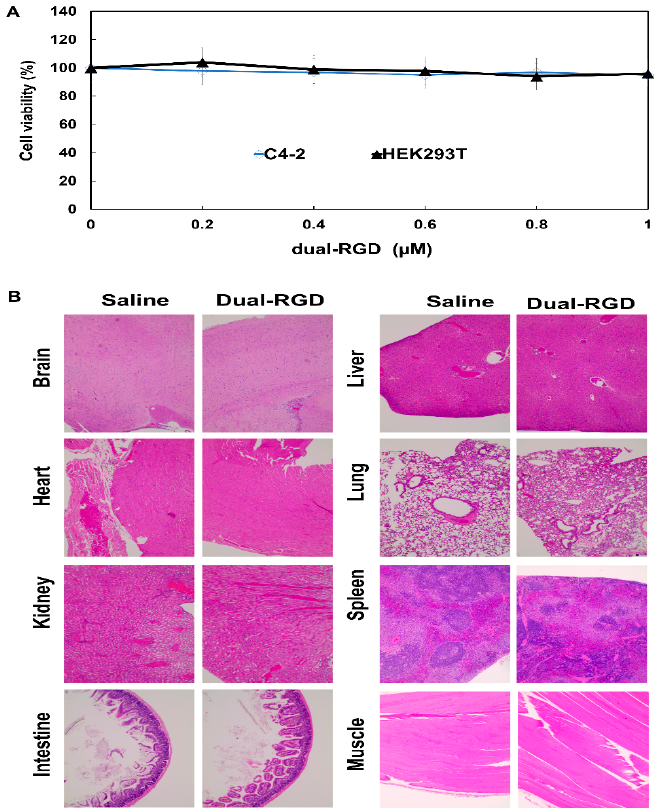
Figure 8. Assessment of toxicity. ( A ) Cell viability assay. Integrin α v β 3 -negative C4-2 and HEK293 cells were treated with the varying concentrations of dual-RGD for 72 h. CCK-8 reagent was